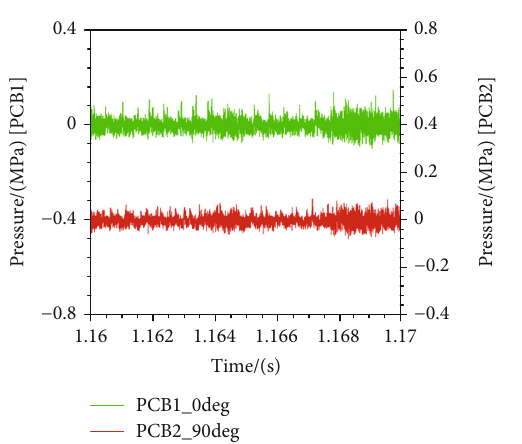
Figure 10: Propagation frequency of Test #2.